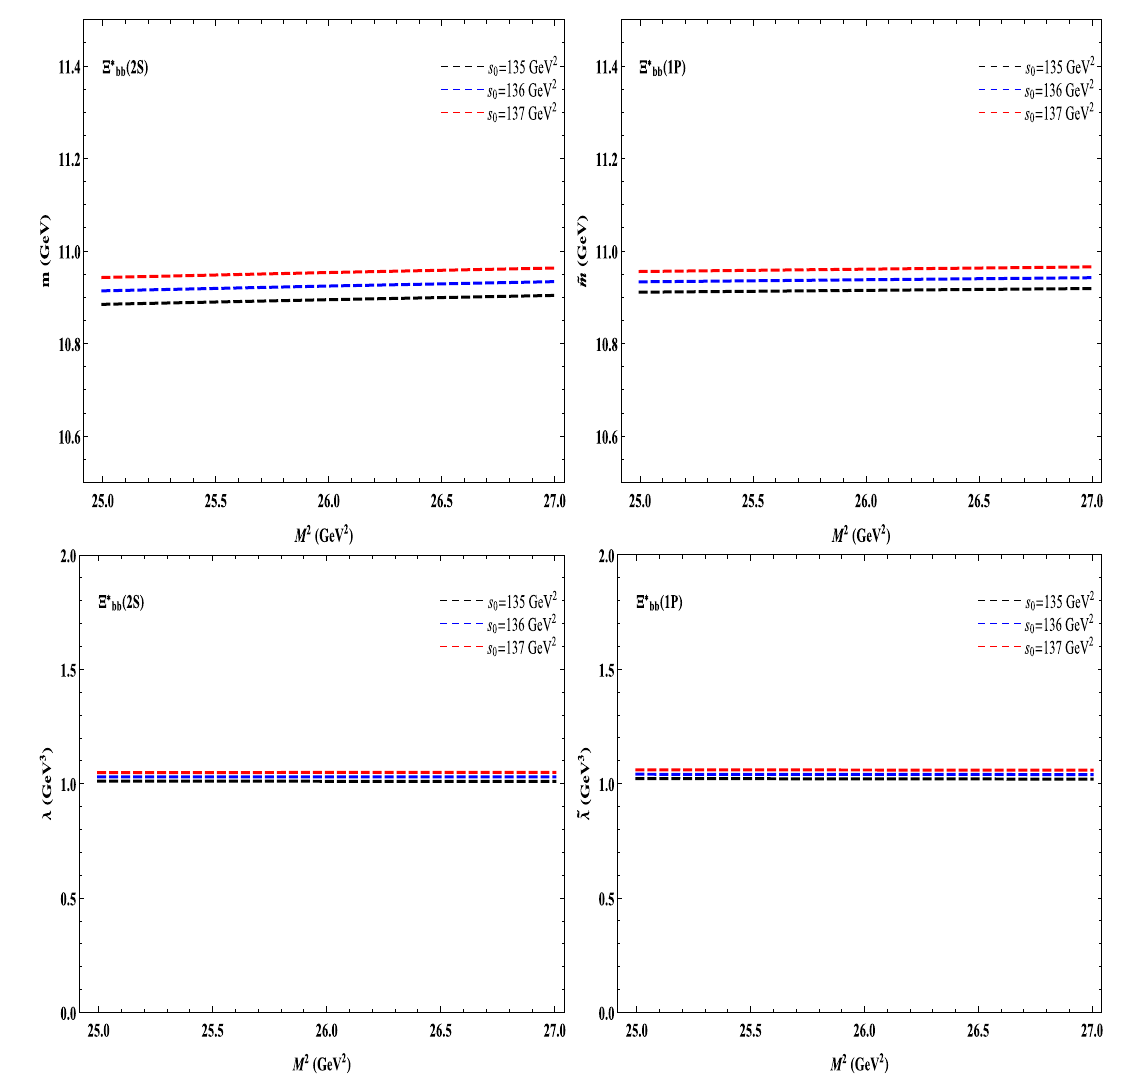
Fig. 4 The dependency of the excited states 2 S , 1 P masses, and pole residues of the doubly-heavy of spin-(3/2) (cid:2) ∗ M 2 at different values of the continuum threshold s